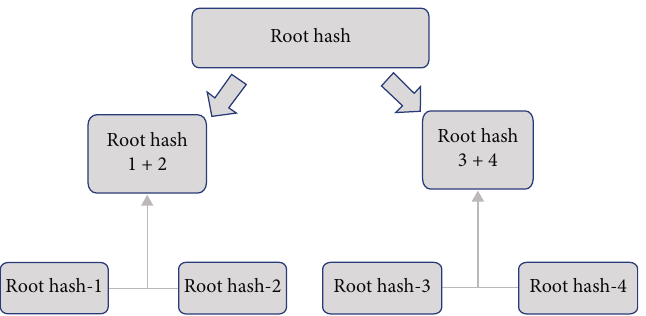
Figure 11: Root hash parameter assignment process.